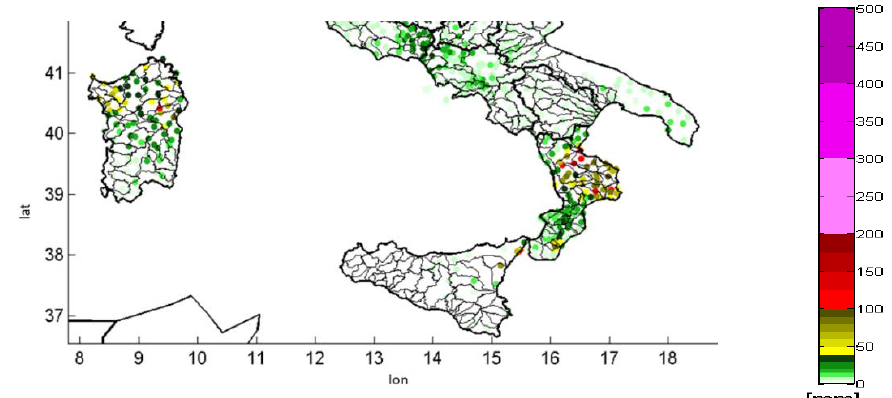
Figure A1. Example of rain-gauge accumulation over the selected spatio-temporal domain.